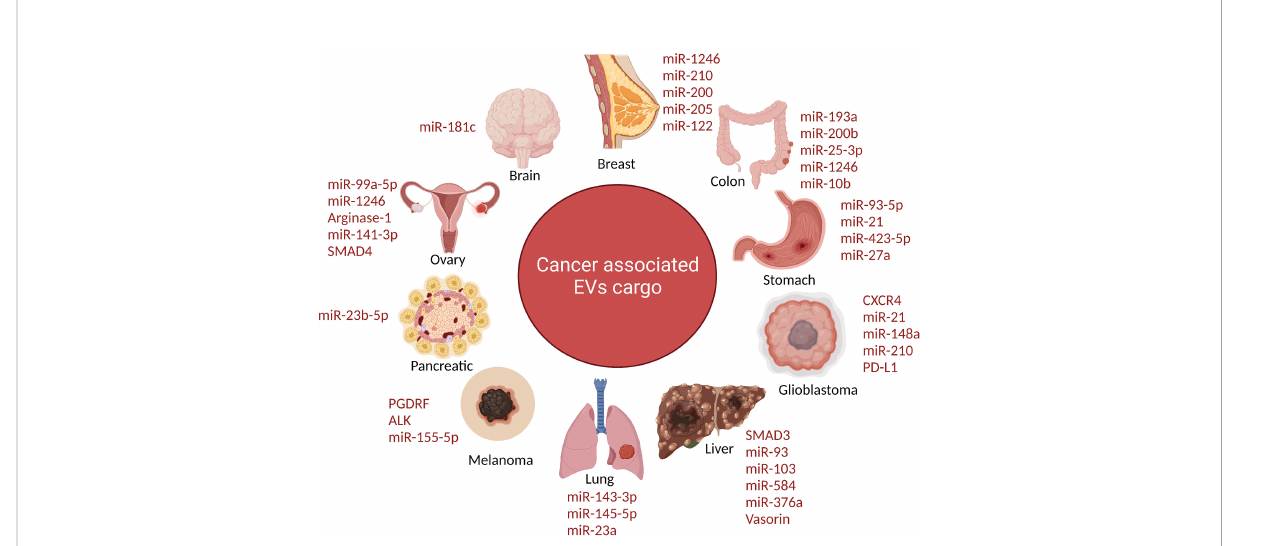
FIGURE 2 The schematic diagram depicts the extracellular vesicles derived from tumor contain distinct protein cargo which promote tumor progression. Tumor-derived EVs carry a speci fi c protein cargo that aids tumour development. Components in the cargo of TEX (tumor-derived sEVs) cause immune cells to fail in diverse ways, inhibiting the antitumor immune response. TEX initially interacts with immune cells via ligands or antigens that lymphocytes identify through corresponding receptors. TEX binds to the surface membrane before being absorbed into the cytoplasm through